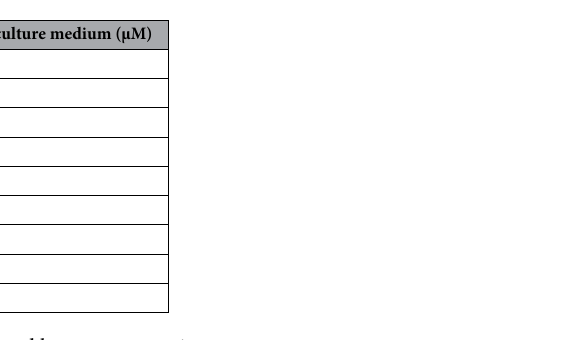
Table 1. Summary of the conditions analyzed by gene